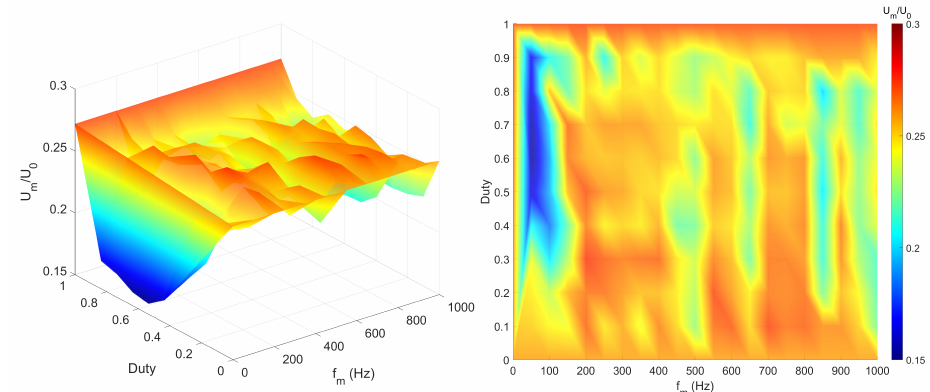
Figure 13. Surface plot and heat scatter plot ( f m vs. duty vs. velocity ) while θ = π at centerline where x / h =